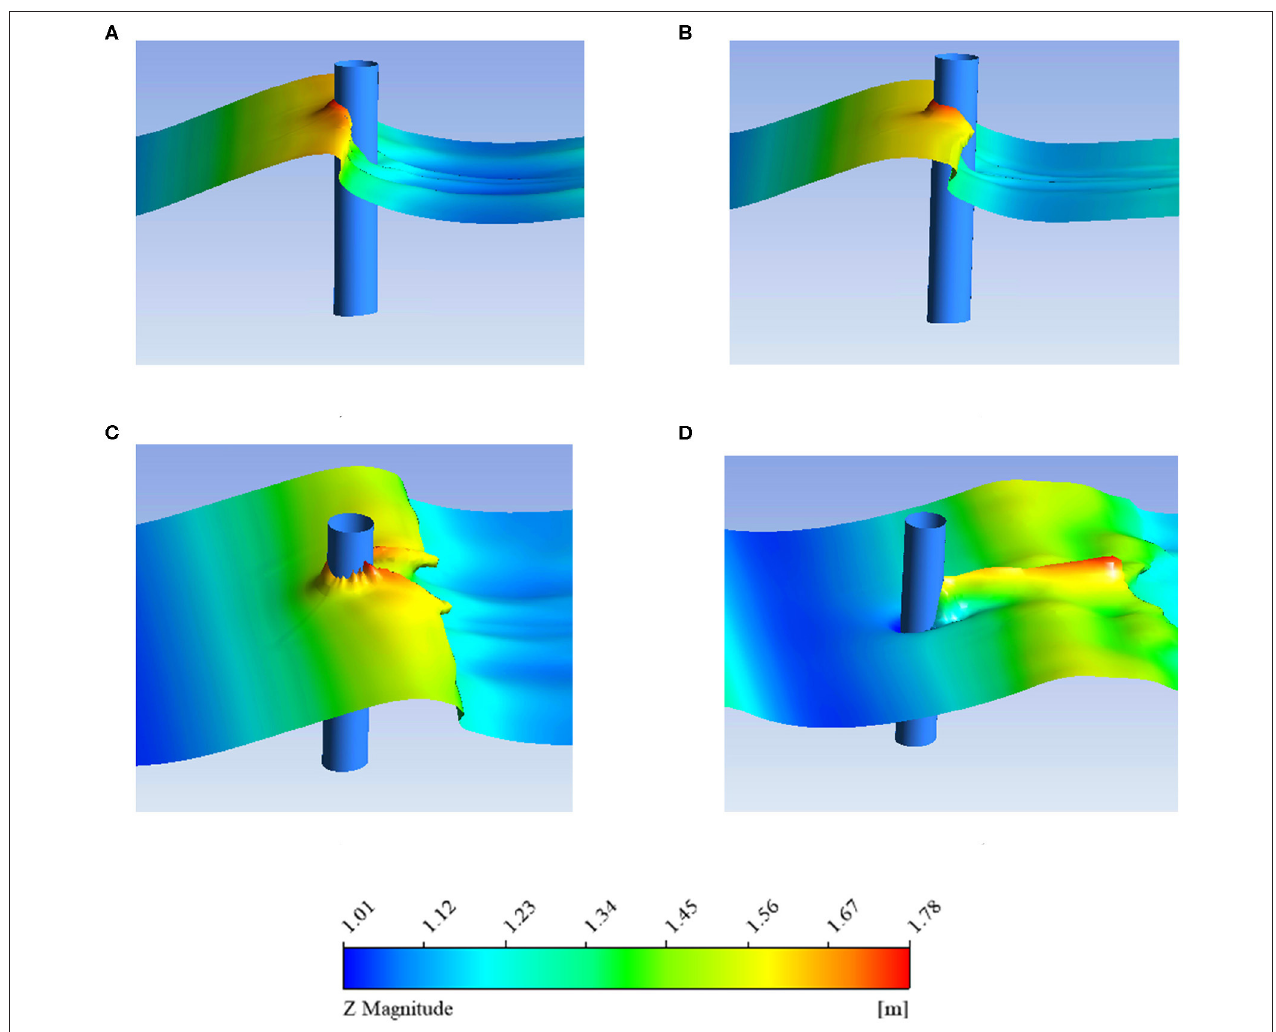
FIGURE 7 | Breaking wave ( ξ 0 = 0.178) flow around the monopile foundation. (A) time = 9s; (B) time = 9.16s; (C) time = 9.48s; (D) time =